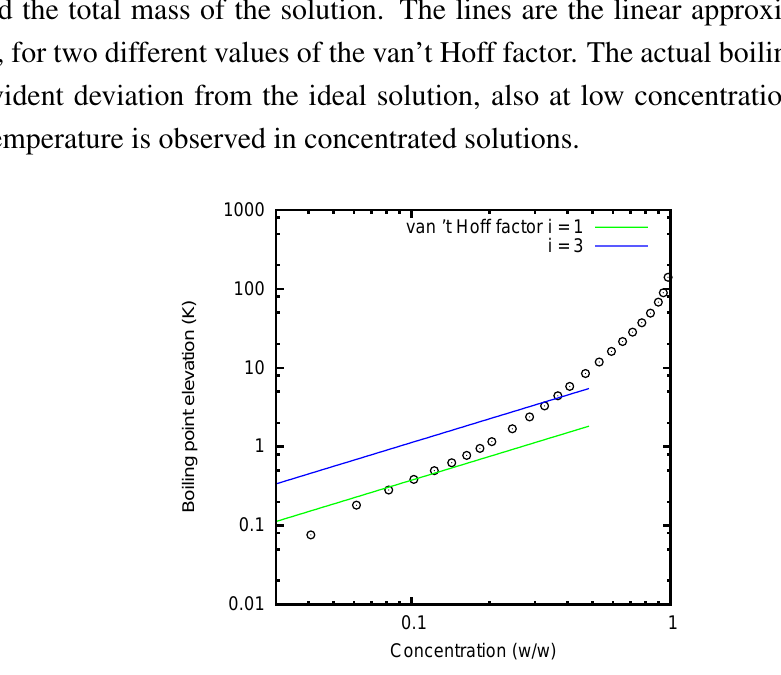
Figure 5. The available free energy. The graph shows the energy that can be ideally produced by a cell per liter of solvent in the diluted solution, as a function of the concentration of the outgoing diluted solution. The concentrated solution has a mass fraction C considered constant during the cycle, c with the cell filled with fresh water, c